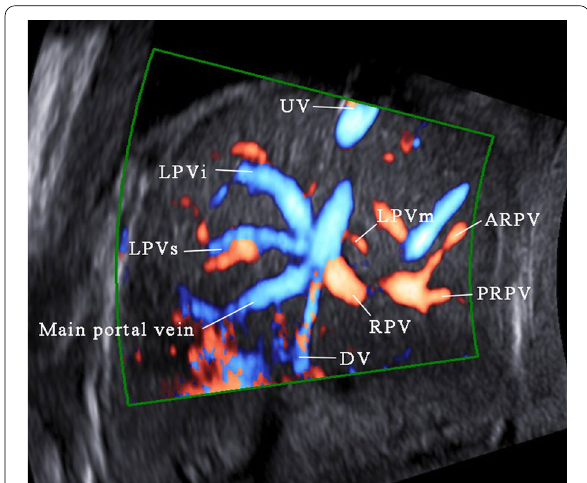
Fig. 1 The ultrasonographic image of the normal fetal umbilical– portal venous